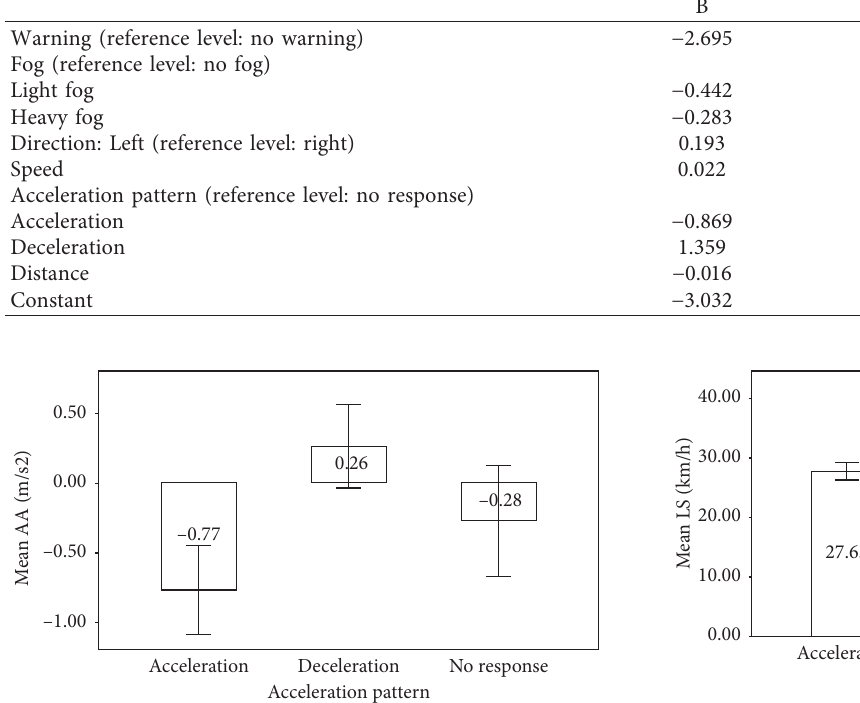
Figure 12: Fitted mean profiles of LS with respect to acceleration